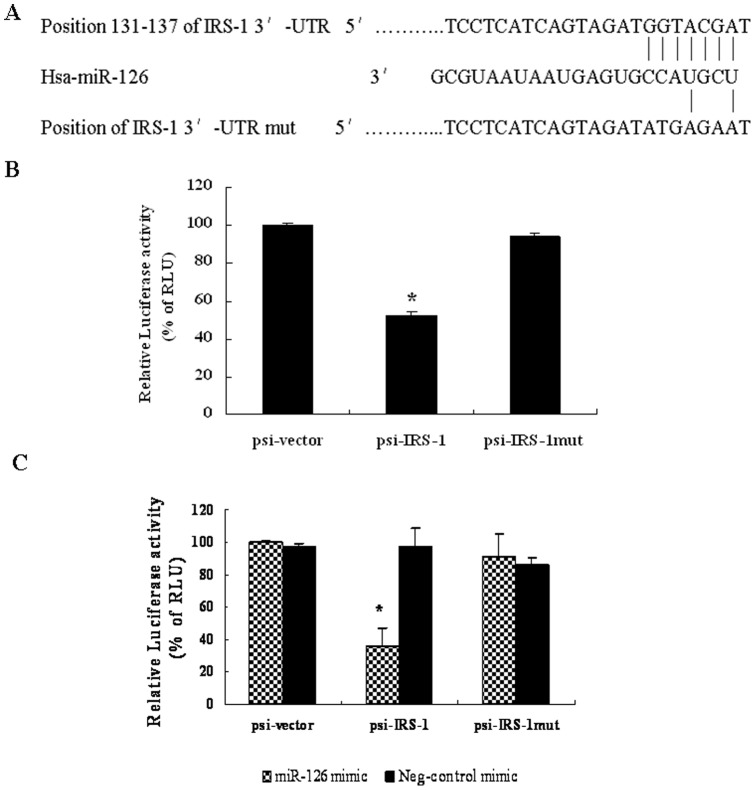
MicroRNA-126 (miR-126) targeting the 3′-untranslated region (UTR) of the insulin receptor substrate 1 (IRS-1).(A) Position of the miR-126 target site in the 3′-UTR of the IRS-1 mRNA predicted by TargetScan. HT-29 cells were transfected with either the original dual luciferase reporter vector (psi-vector) or an IRS-1 3′-UTR construct with the wild type miR-126 binding site (psi-IRS-1) or the mutated miR-126 binding site (psi-IRS-1-mut). Relative Renilla luciferase activity (normalized to Firefly luciferase activity) was measured 24 h post-transfection. (B) Relative Renilla luciferase activity was reduced in cells transfected with the wild type IRS-1 3′-UTR construct (psi-IRS-1) compared to those transfected with the psi-vector (500 ng/well of a 24-well-plate). Relative Renilla luciferase activity was restored in cells transfected with the mutant construct (psi-IRS-1mut). (*P<0.05, compared to that of psi-vector). (C) Co-transfection of HT-29 cells with 50 nM miR-126 mimic and various luciferase reporter constructs (500 ng/well) reduced the relative Renilla luciferase activity. (*P<0.05, compared to that of psi-vector). Data are presented as mean ± SEM of three independent experiments.